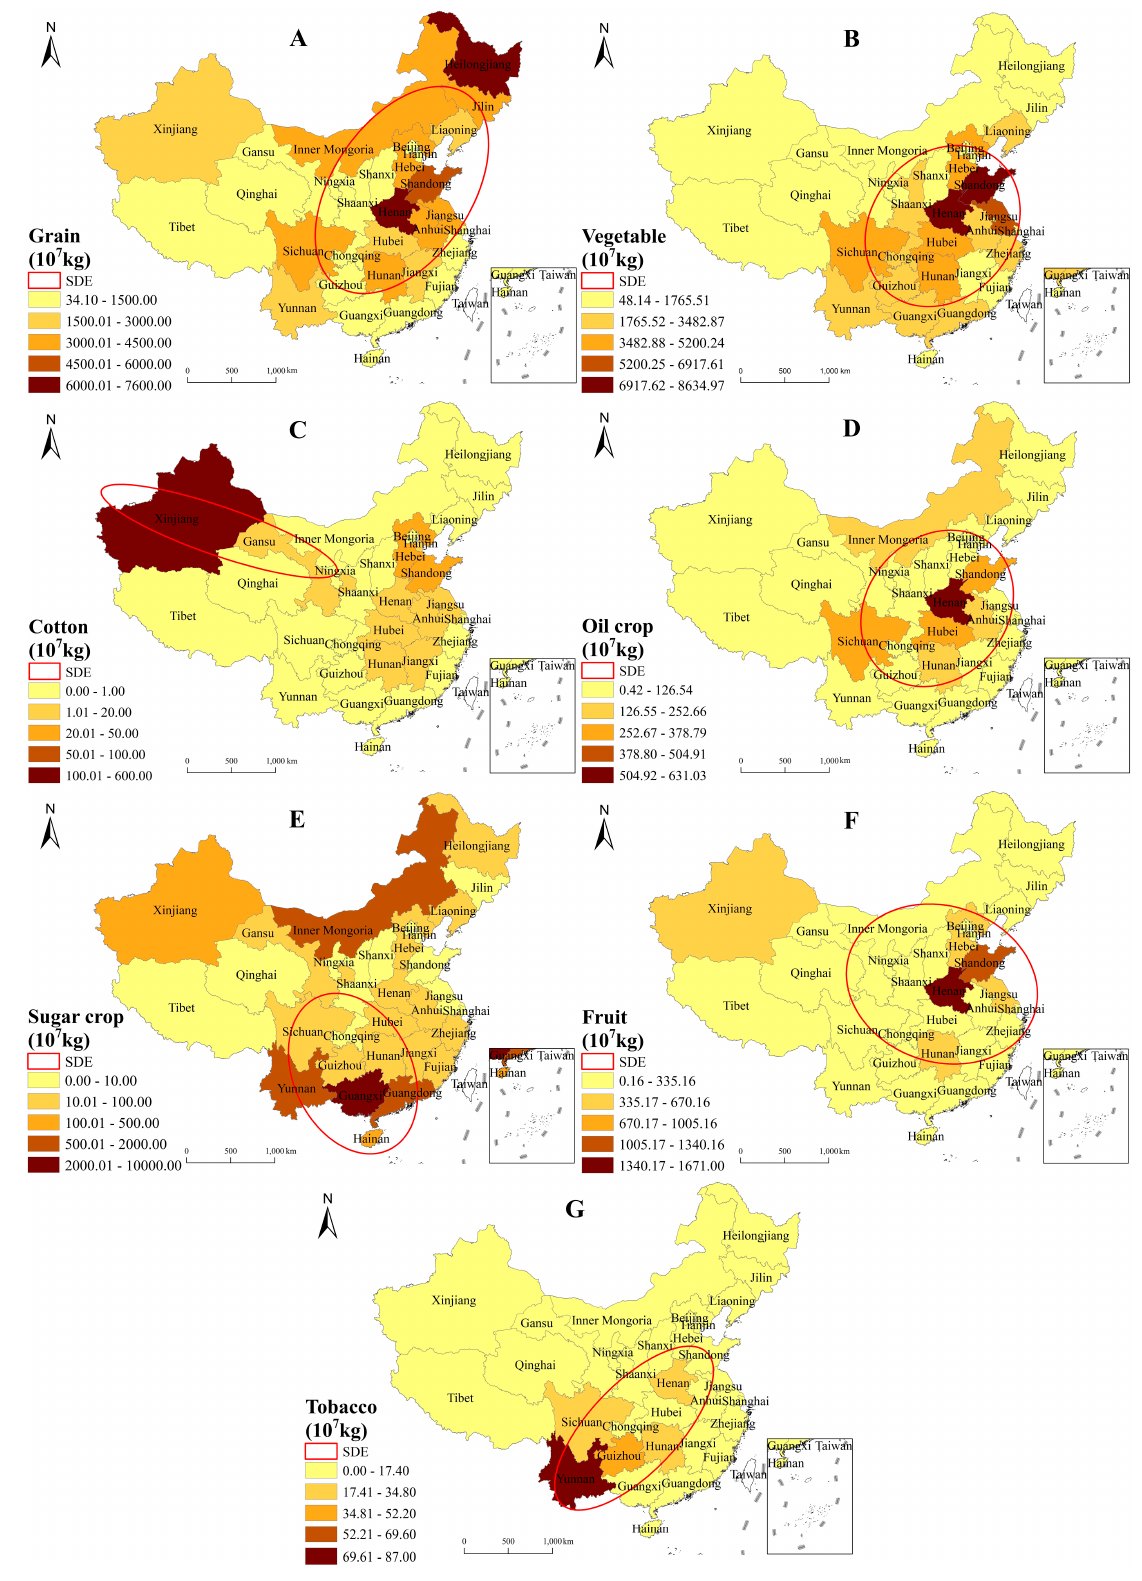
Figure 7. Output of crop yields on arable land in 2018.